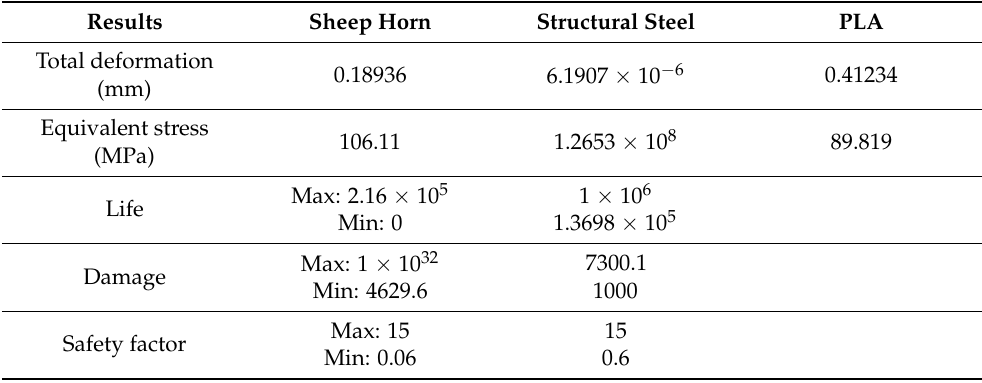
Table 7. Simulation study comparison for tortoise vertebral